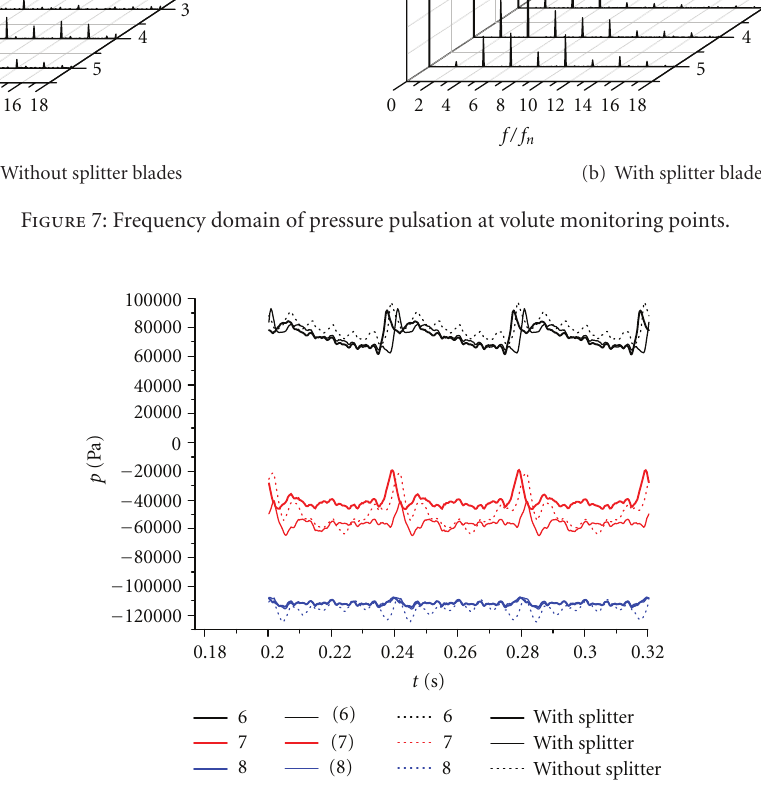
Figure 8: Time domain of pressure pulsation at impeller monitoring